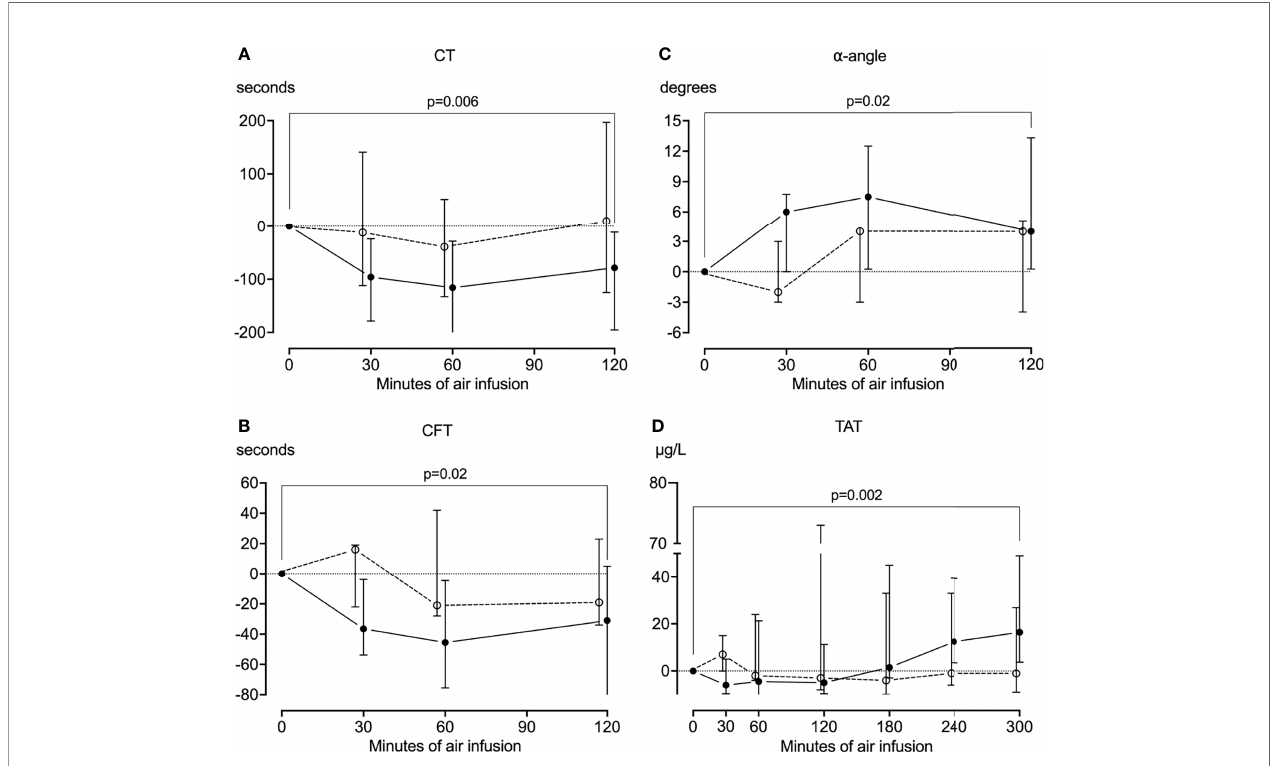
FIGURE 5 | Coagulation. Whole blood was drawn from the animals every half hour for the fi rst two hours of the experiments, and the coagulation was analyzed using rotational thromboelastometry (ROTEM). In animals receiving air infusion, a signi fi cant reduction from baseline in the clotting time (A) and clot formation time (B) and a signi fi cant increase from baseline in the a -angle (C) was observed. These parameters mainly remained at baseline in sham animals, albeit with a pronounced heterogenicity. (D) Plasma was drawn from the animals throughout the experiments and analyzed for thrombin-antithrombin (TAT) using ELISA. TAT increased signi fi cantly from baseline in pigs receiving air infusion and remained at baseline in sham animals. Solid line represents pigs receiving air infusion. Dotted lines are sham animals. Circles represent medians, and error bars span the interquartile